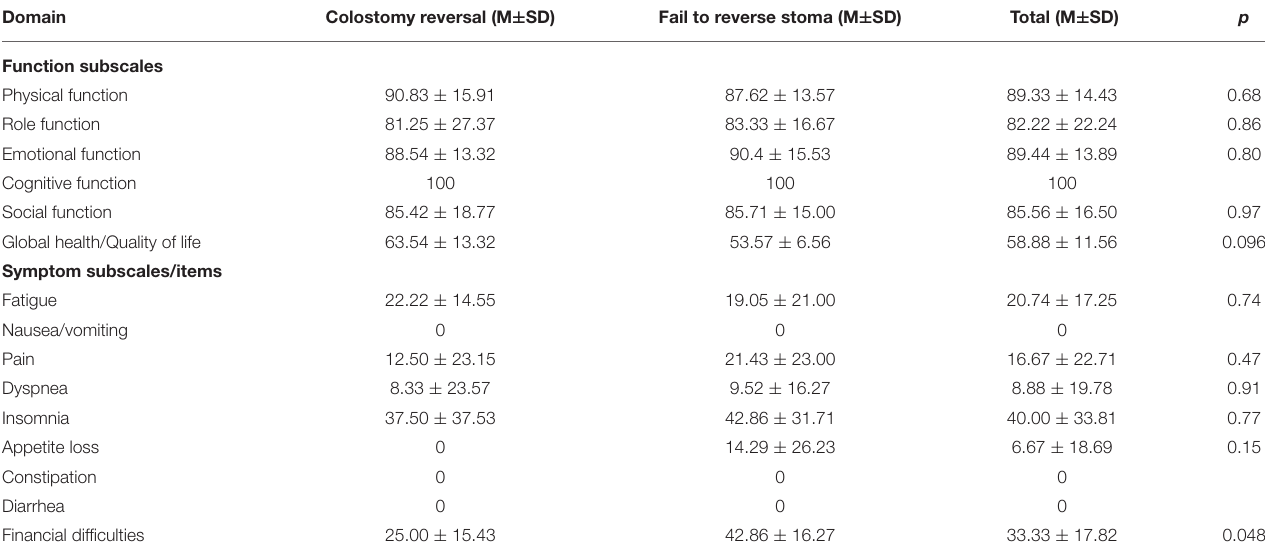
TABLE 5 | Evaluation of quality of life in patients underwent the PE-Bacon.